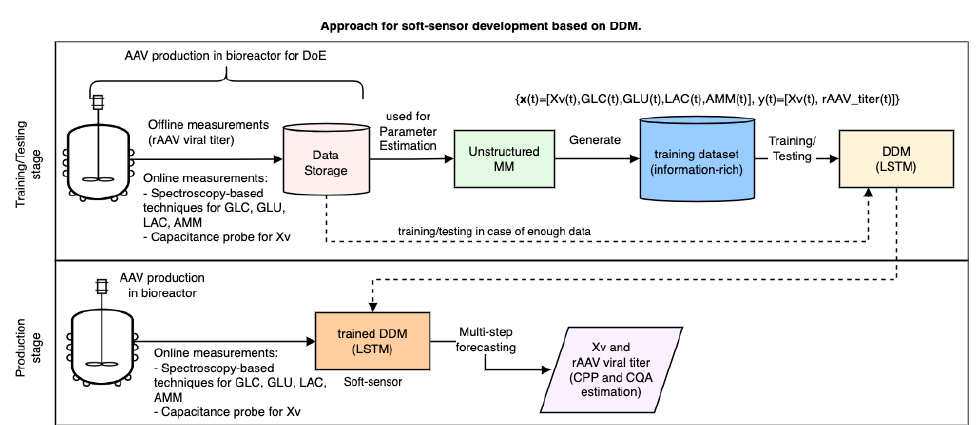
Figure 1. Soft sensor development approaches based on DDM for rAAV production monitoring. A possible approach is use unstructured MM to generate an information-rich training dataset and DDM for multi-step forecasting of rAAV viral